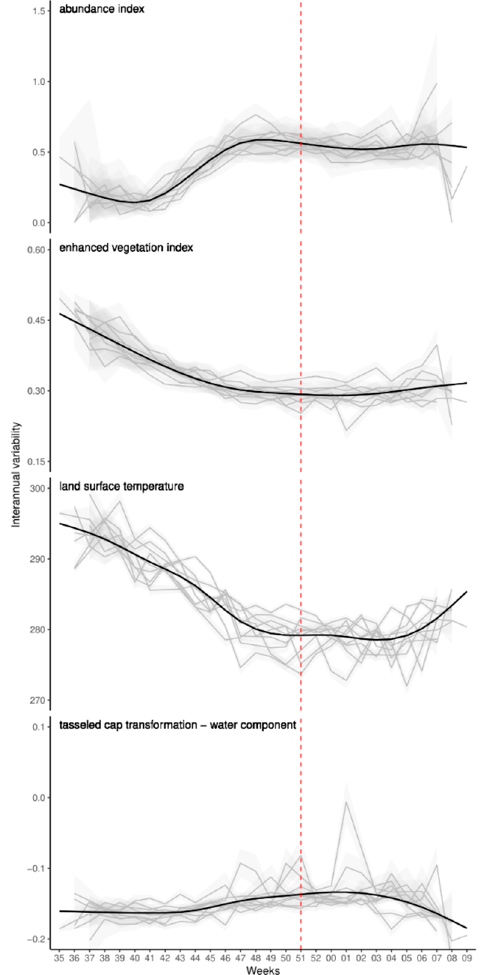
Figure 2. Variation over each hunting season (2009/2010 to 2017/2018) of the values (mean and respective 95% confidence interval—shaded) of the relative abundance of Woodcock, EVI—enhanced vegetation index, TCTwet—tasseled cap transformation—water component, and LST—land surface temperature. The numbering of weeks corresponds to that used in the civil calendar; week “00” corresponds to the week that includes December and January days. The red dashed line indicates the separation between the periods of autumn migration (left) and wintering (right).